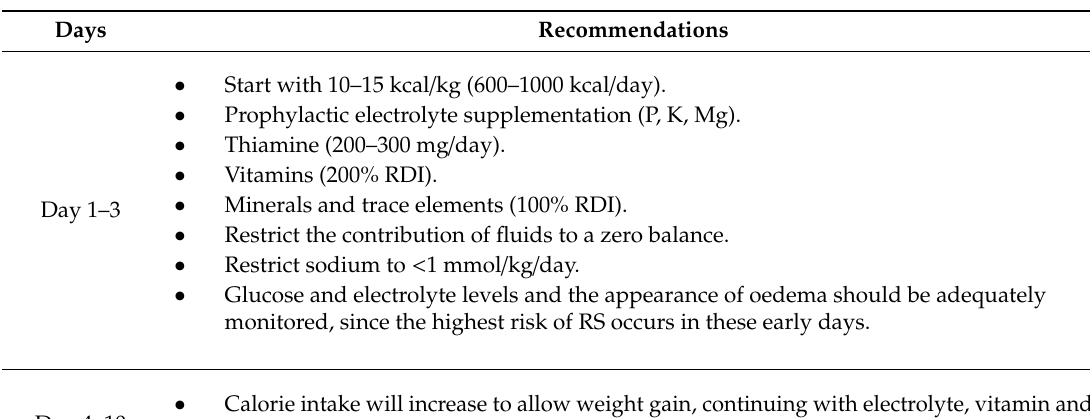
Table 5. Example of a refeeding process in terms of macronutrient and micronutrient intake [19].